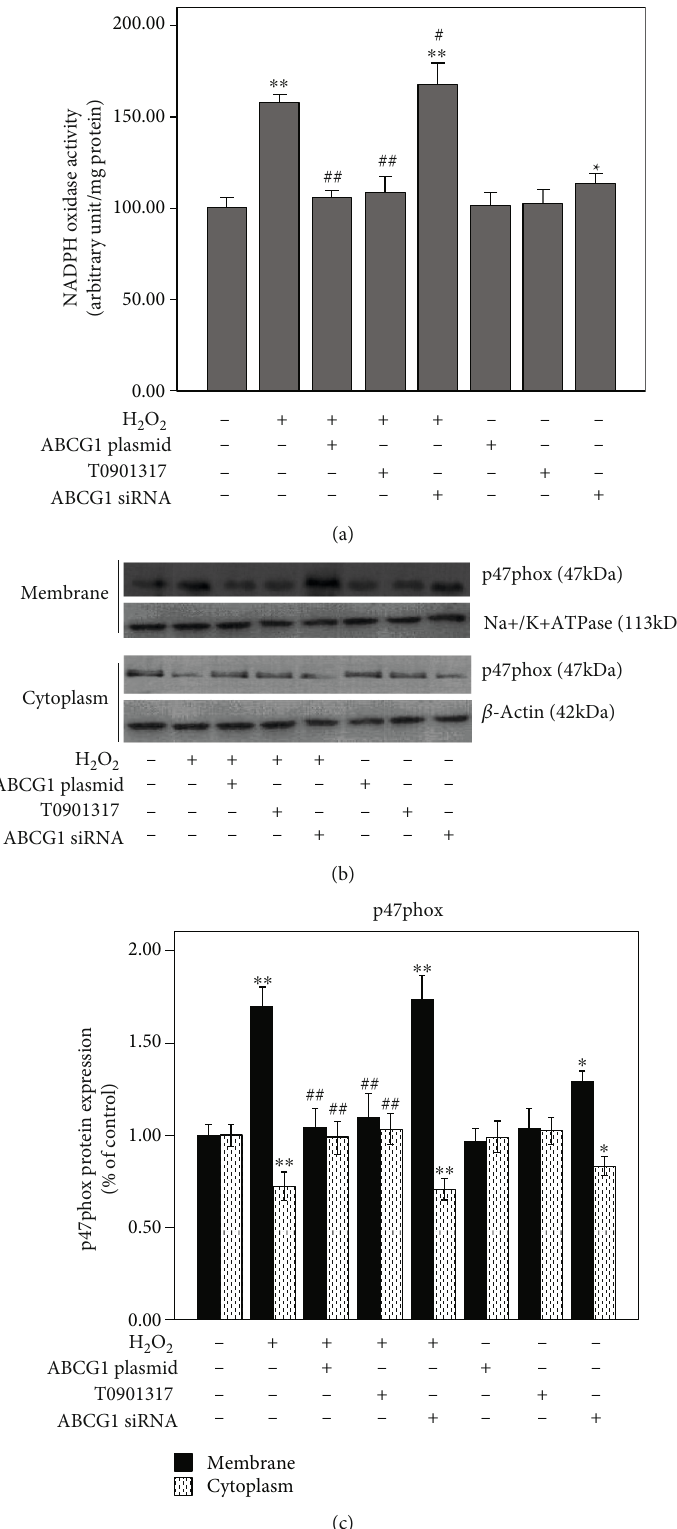
O for 12h or not. At the end of the incubation, NADPH 2 2